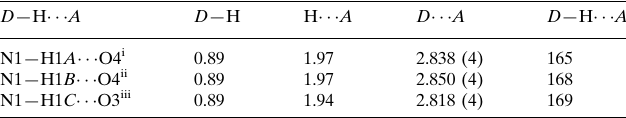
Hydrogen-bond geometry (A˚ , (cid:3)